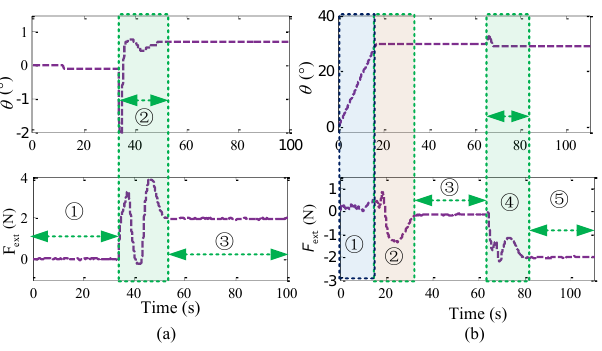
Figure 22. The partition of the experimental results curve.